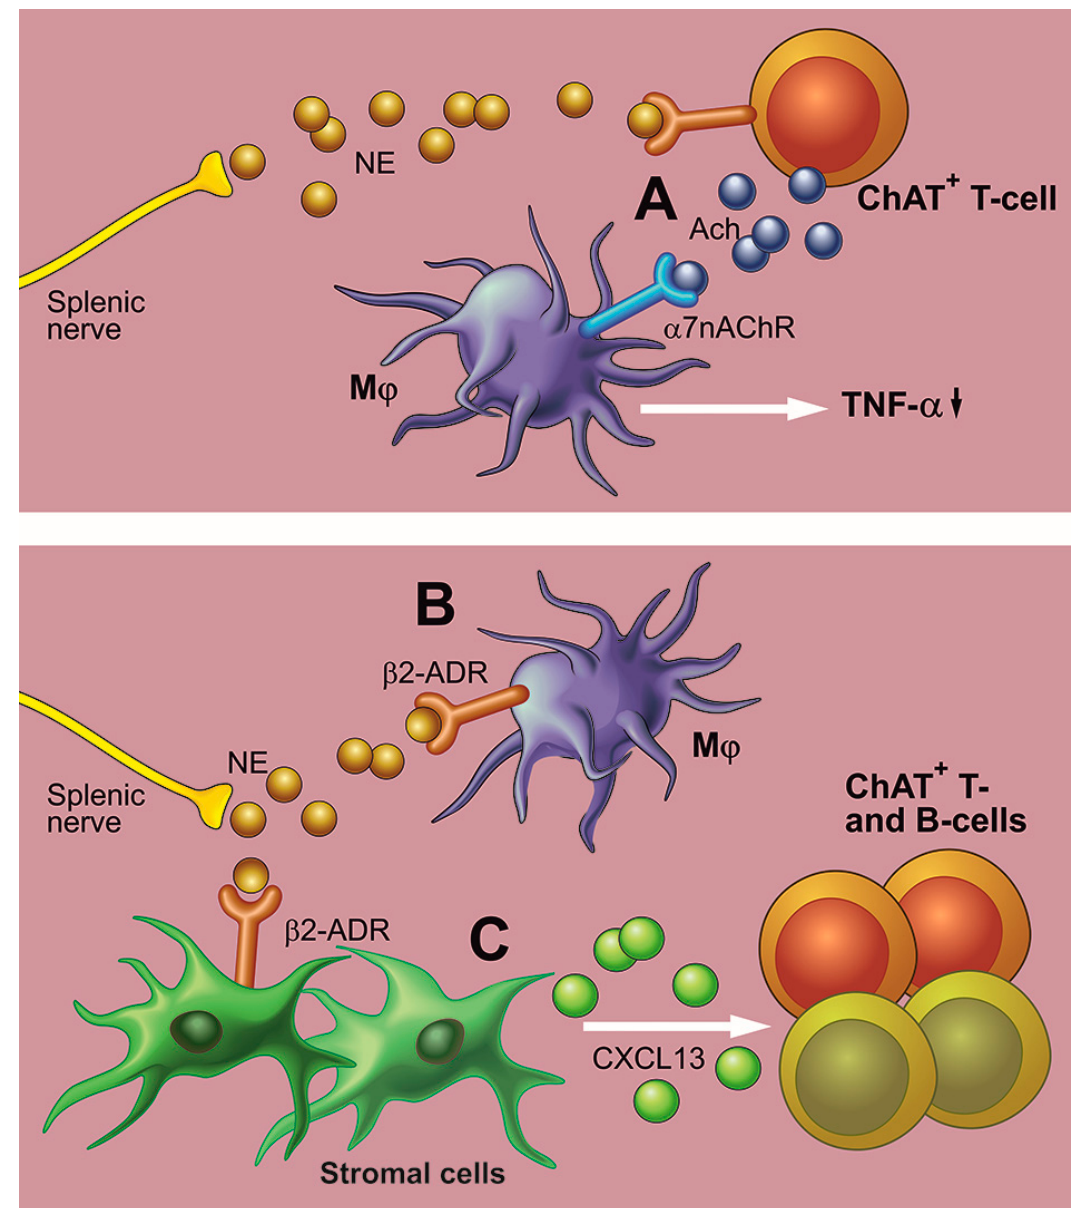
Figure 2. Mechanisms via which stimulation of the splenic nerve controls inflammation. ( A ) Stimulation of the splenic nerve causes the release of norepinephrine (NE), which binds to receptors on the choline acetyltransferase (ChAT) + T-cells. These cells produce acetylcholine (ACh), which reduces the production of inflammatory cytokines such as tumor necrosis factor (TNF)- α by binding to the α 7 nicotinic acetylcholine receptor ( α 7nAChR) of macrophages [68] . ( B ) The released NE directly binds to β 2-adrenergic ( β 2-ADR) on macrophages (or other target cells). ( C ) Upon activation by NE, splenic stromal cells produce chemokines, such as chemokine (C-X-C motif) ligand (CXCL) 13, which control the distribution of ChAT + lymphocytes [72] . M ϕ —macrophage.